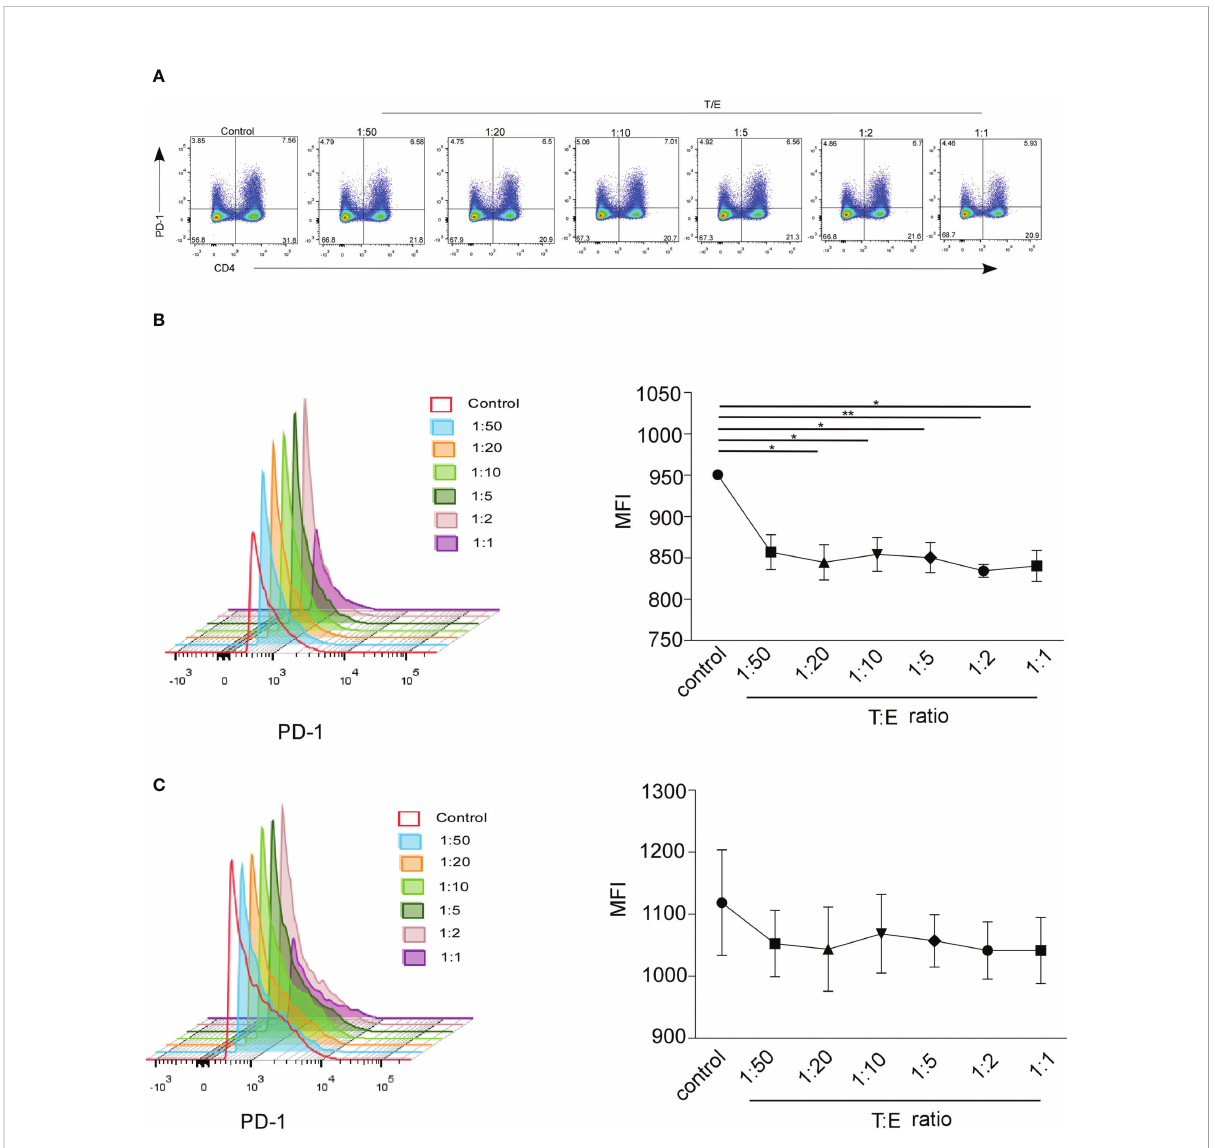
FIGURE 5 The MFI of mPD-1+ CD4+/CD8+T cells from healthy control was analyzed by FACS. Peripheral blood mononuclear cells (PBMCs) were treated 24 h with different concentrations of estrogen (10, 20, and 50 nmol) and androgen (1 and 10 nmol). (A) Frequency of CD4+/CD8-PD-1+ cells and CD4-/CD8+PD-1+ cells which gated on CD3+T cells treated with the ratio of T/E at 1:50 (1 nmol androgen and 50 nmol estrogen), 1:20 (1 nmol androgen and 20 nmol estrogen), 1:10 (1 nmol androgen and 10 nmol estrogen), 1:5 (1 nmol androgen and 5 nmol estrogen); 1:2 (1 nmol androgen and 2 nmol estrogen), and 1:1 (1 nmol androgen and 1 nmol estrogen) (healthy donor, n = 3). The MFI of CD8+PD-1+T cell (B) and CD4+PD-1+T cell (C) in PBMCs with the ratio of T/E at 1:50, 1:20, 1:10, 1:5, 1:2, and 1:1. * P < 0.05, ** P < 0.01. Mann – Whitney test (two-tailed) and paired Student ’ s t -test. T/E, androgen/estrogen; MFI, mean fl uorescence